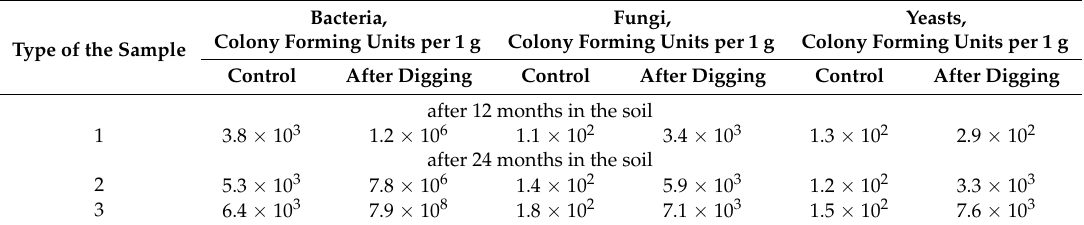
Table 2. Degree of microbiological contamination of the geotextile nonwoven materials.